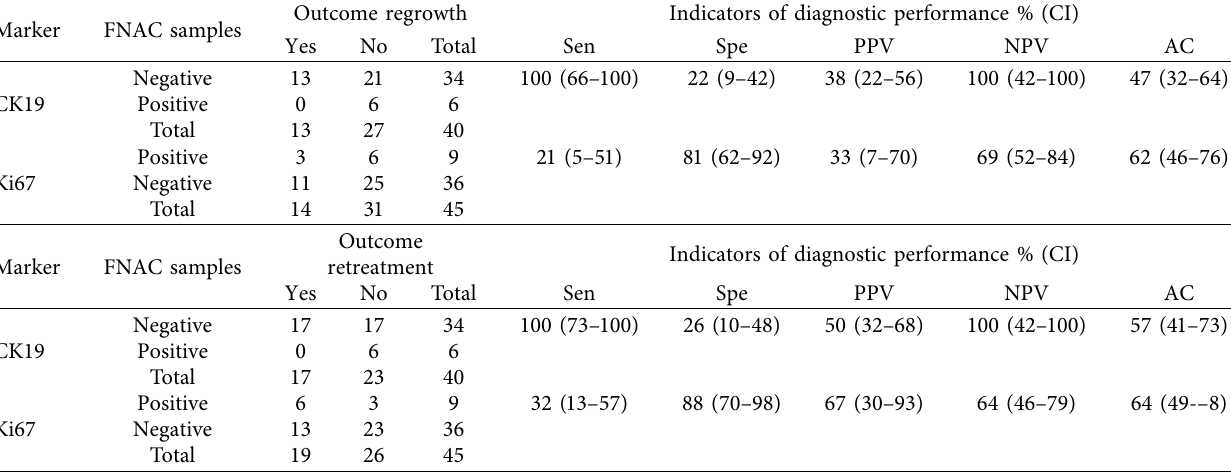
Table 3: Predictive value of biomarkers for response to thermal ablation.